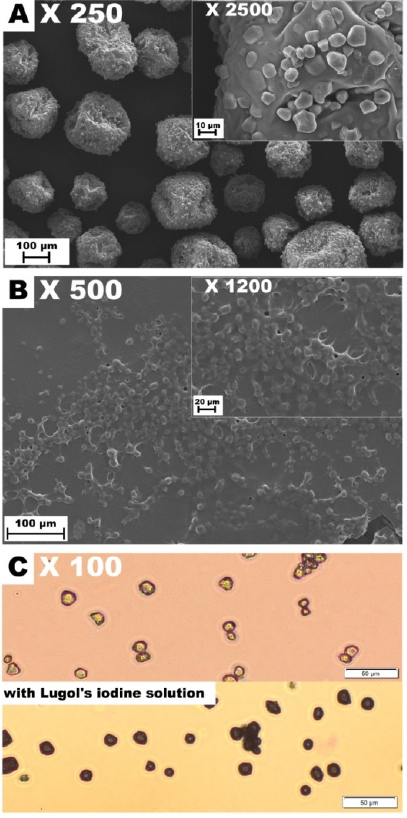
Figure 2. Images of AstaSana powder ( A ) and the dehydrated AstaSana aqueous solution examined using the scanning electron microscopy ( B ). The aqueous solution of AstaSana examined using the optical microscopy ( C ).